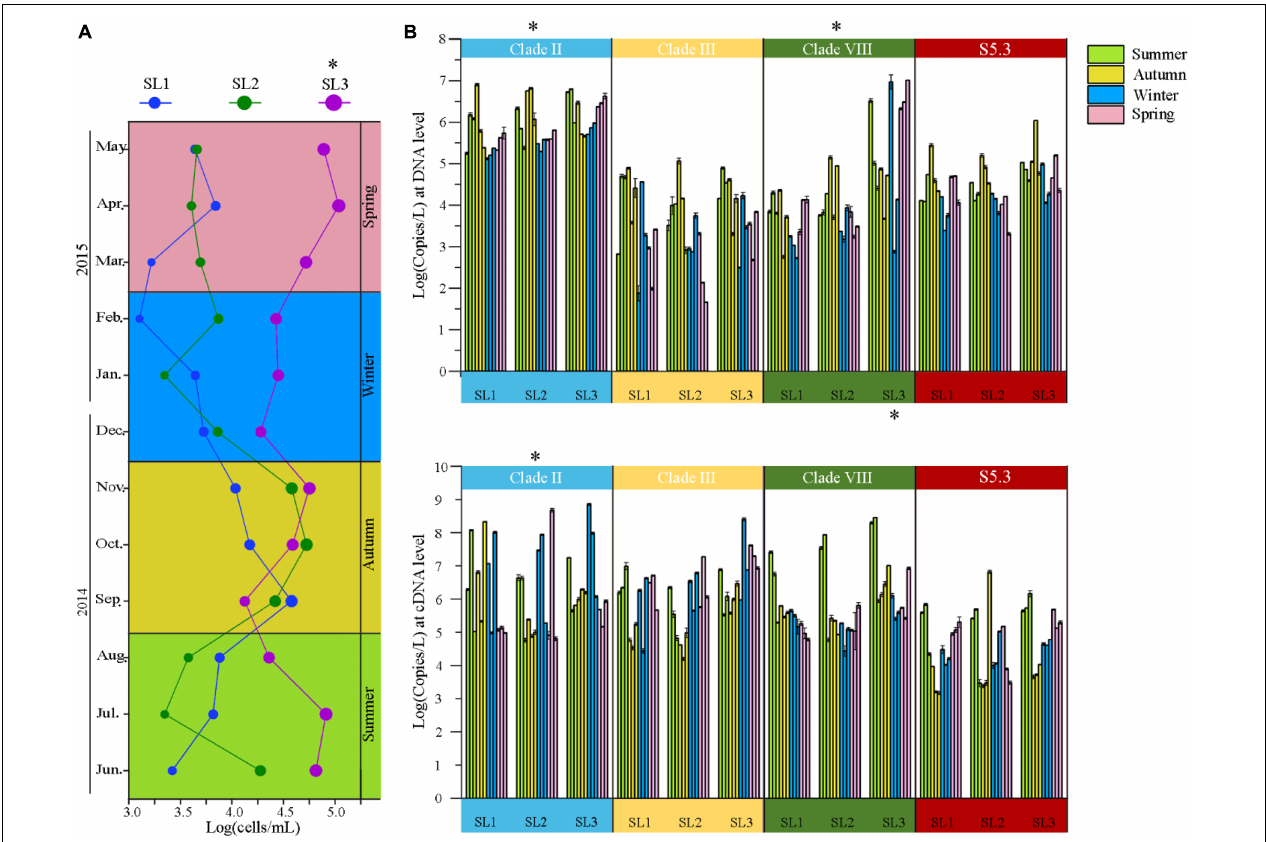
FIGURE 2 | (A) Temporal variation of Synechococcus cell abundance at three stations. (B) Gene (top panel) and gene transcript (bottom panel) abundance of Synechococcus lineages at three stations. * – p < 0.05; Summer, June to August; Autumn, September to November; Spring, December to February; Winter, March to